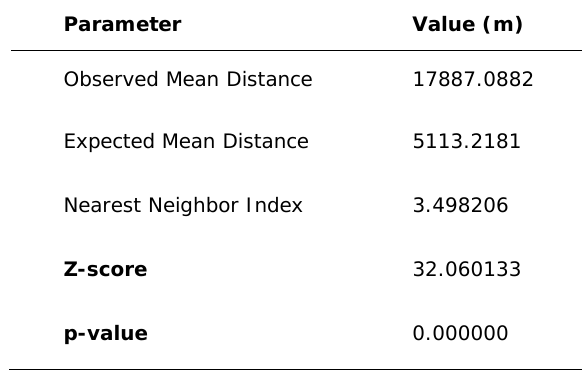
Table 1. Average nearest neighbour